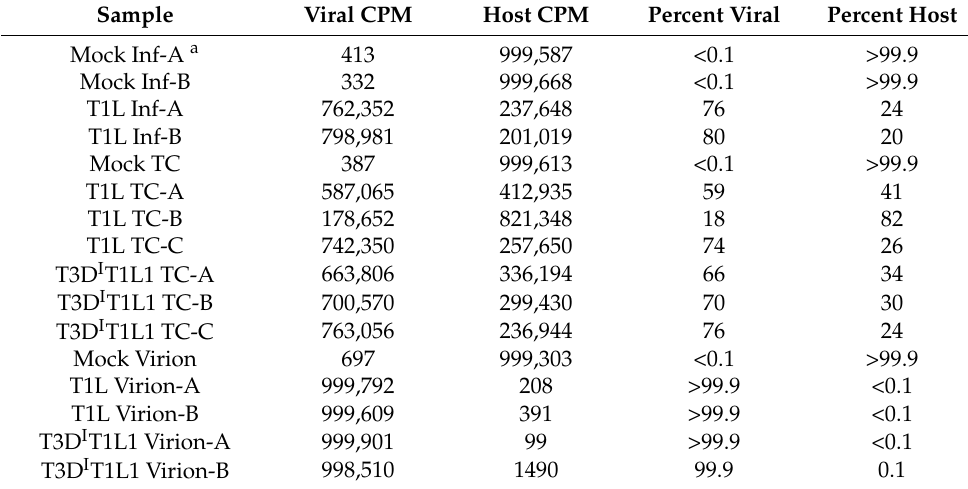
Table 2. Percentage of viral and cellular reads from rsT1L-infected L cells and rsT1L or rsT3D I T1L1 TC particles or